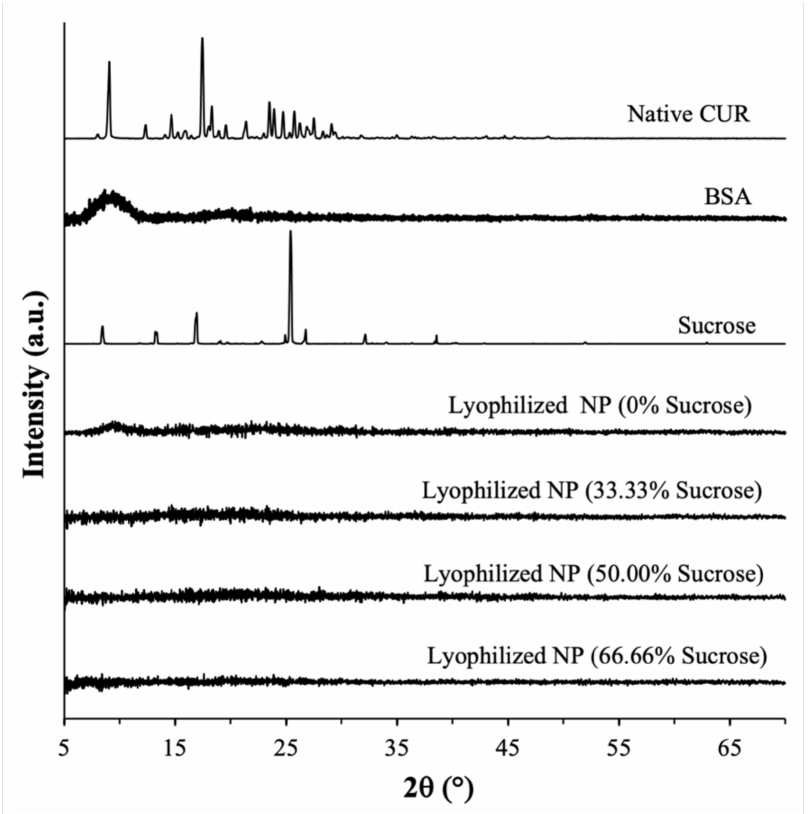
Figure 3. PXRD patterns of the native CUR, BSA, raw sucrose, and lyophilized CUR-BSA nanoplexes prepared at different sucrose mass